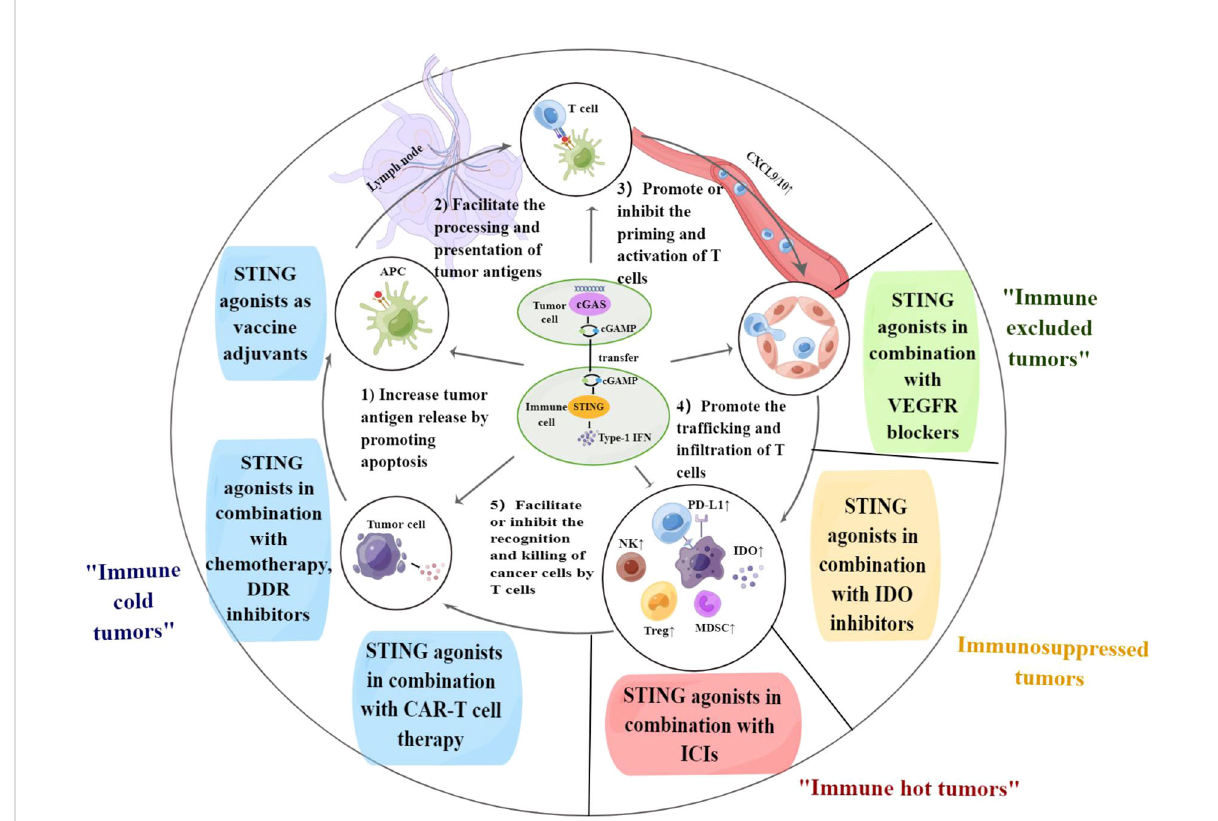
FIGURE 1 The cGAS-STING pathway regulates each step of the cancer-immunity cycle. Combination therapy of STING agonists can target different steps of the cancer-immunity cycle and contribute to solving immunotherapy challenges in the corresponding immune types of tumors. APC, antigen-presenting cell; PD-L1, programmed death-ligand 1; DDR, DNA damage response; VEGF, vascular endothelial growth factor; IDO, indoleamine 2,3-dioxygenase; ICIs, immune checkpoint inhibitors; CAR-T cell, chimeric antigen receptor-T cell. By